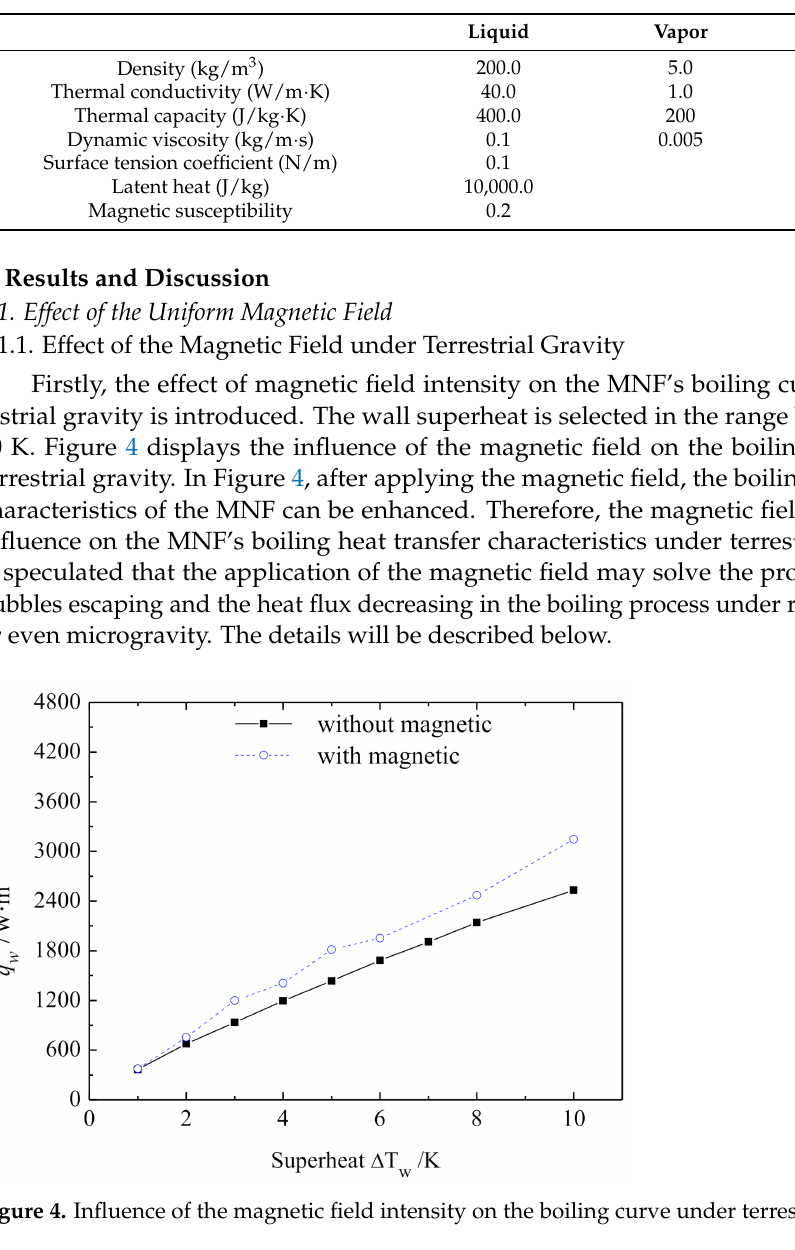
Table 1. Properties of the magnetic nanofluid (MNF).